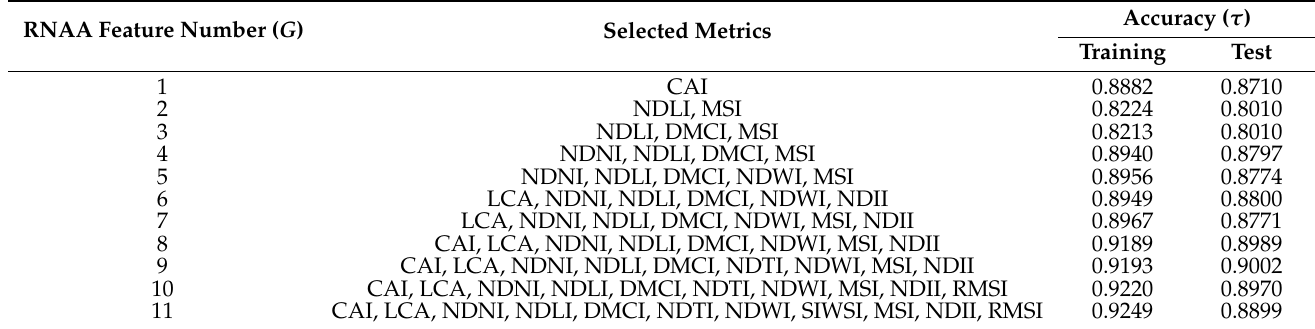
Table 2. HyMap metrics selected from the eleven metrics for TDFs age-attribute learning. RNAA Feature Number ( G ) Selected Metrics